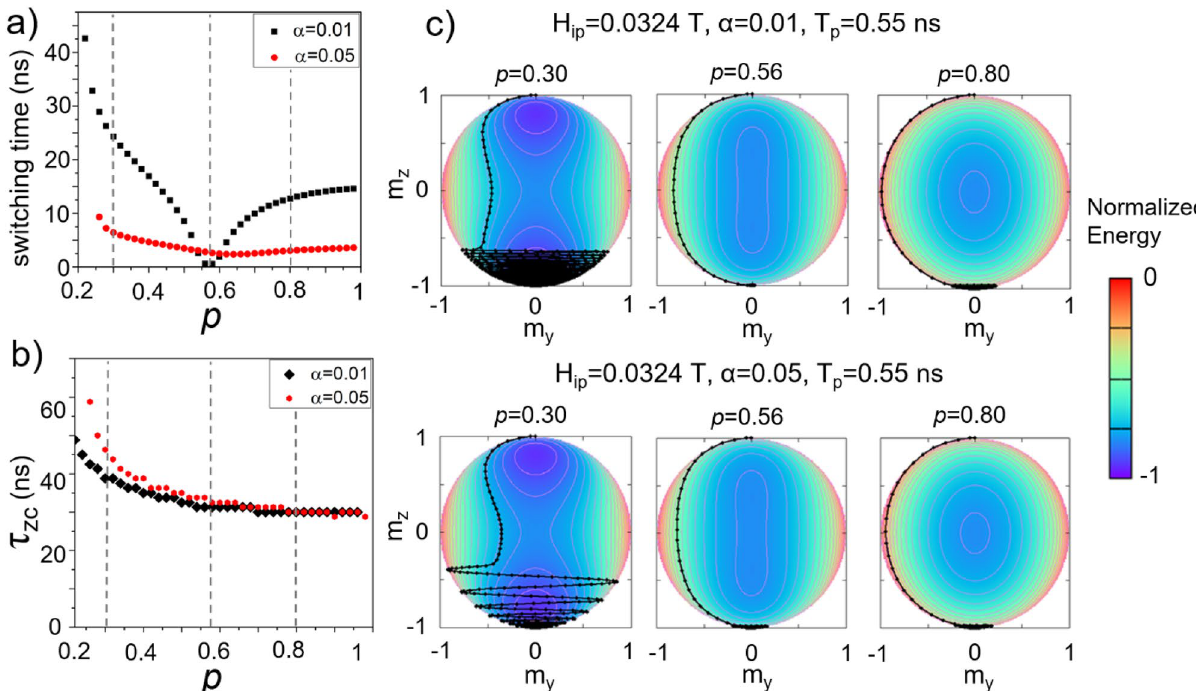
Figure 4. ( a ) Switching time corresponding to the first resonant switching stripe for two different values of the damping constant (pulse duration of 0.55 ns, H ip = 0.0324 T). ( b ) Evolution of the zero-crossing time τ zc necessary for m z to reach the xOy plane versus the anisotropy modulation p for α values of 0.01 and 0.05. ( c ) The magnetization trajectories corresponding to p values of 0.30, 0.56 and 0.80 (dashed lines in ( a ) and ( b )) are represented on a normalized energy surface for α values of 0.01 (top row) and 0.05 (bottom